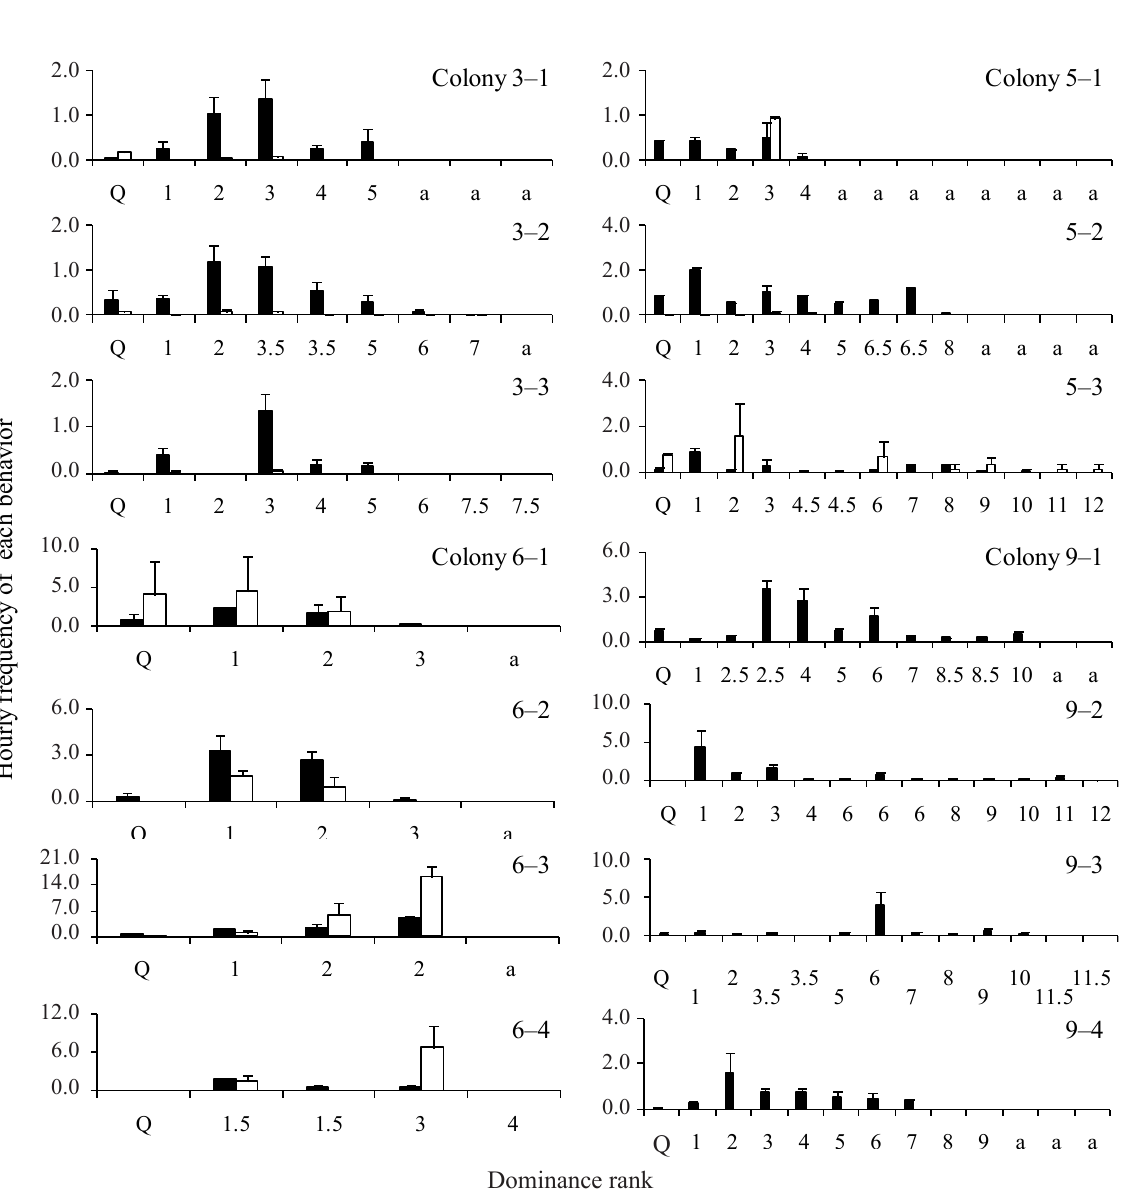
Fig S2 . Hourly frequencies (means and SE values) of aggressive behaviors (solid) and rushing with flapping (open) performed by the queen (Q) and workers, who are ordered according to their dominance ranks based on the